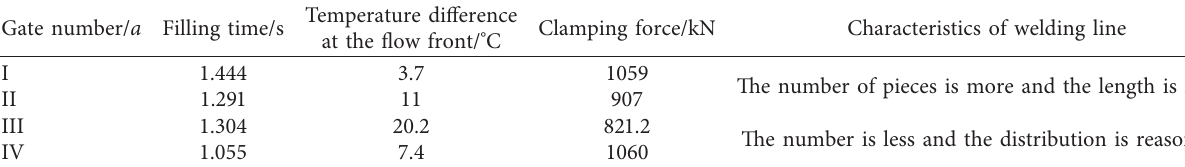
Table 1: Simulation results of the four configurations.